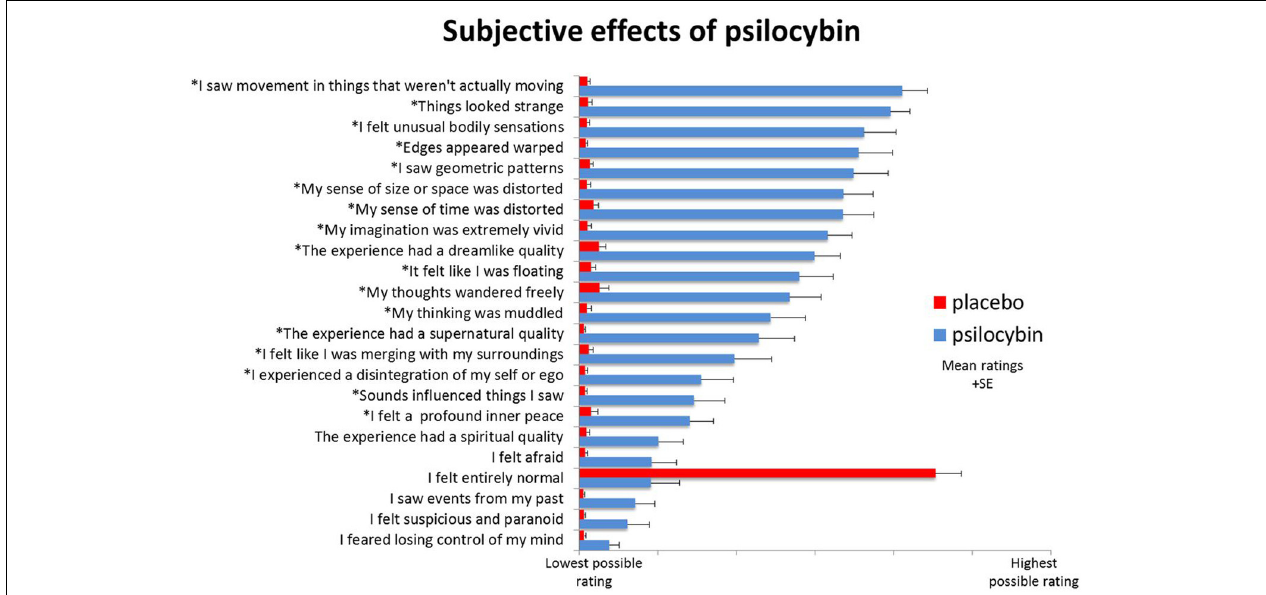
FIGURE 2 | Subjective rating scale items selected after psilocybin (blue) and placebo (red) ( n = 15) (Muthukumaraswamy et al., 2013). “Items were completed using a visual analog scale format, with a bottom anchor of ‘no, not more than usually’ and a top anchor of ‘yes, much more than usually’ for every item, with the exception of ‘I felt entirely normal,’ which had bottom and top anchors of ‘No, I experienced a different state altogether’ and ‘Yes, I felt just as I normally do,’ respectively. Shown are the mean ratings for 15 participants plus the positive SEMs. All items marked with an asterisk were scored significantly higher after psilocybin than placebo infusion at a Bonferroni-corrected significance level of p < 0.0022 (0.5/23 items)” (Muthukumaraswamy et al., 2013, p.